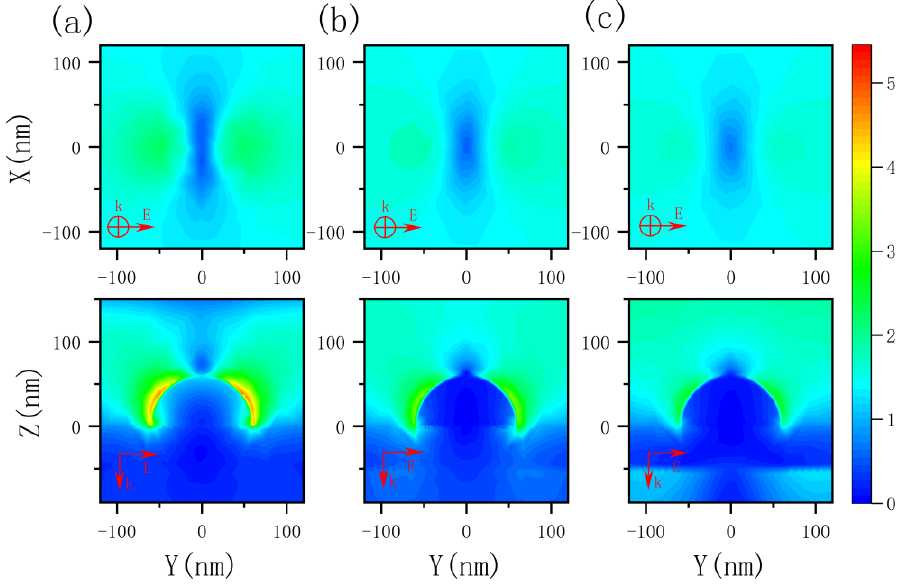
Figure 4. Electric field enhancements ( |𝐸| ) of the silver nanoscale hemisphere at different wave- |𝐸 0 | lengths of ( a ) 400 nm, ( b ) 535 nm, and ( c ) 650 nm. Top row, top view at 10 nm directly above the hemisphere; bottom row, longitudinal section of the structure.